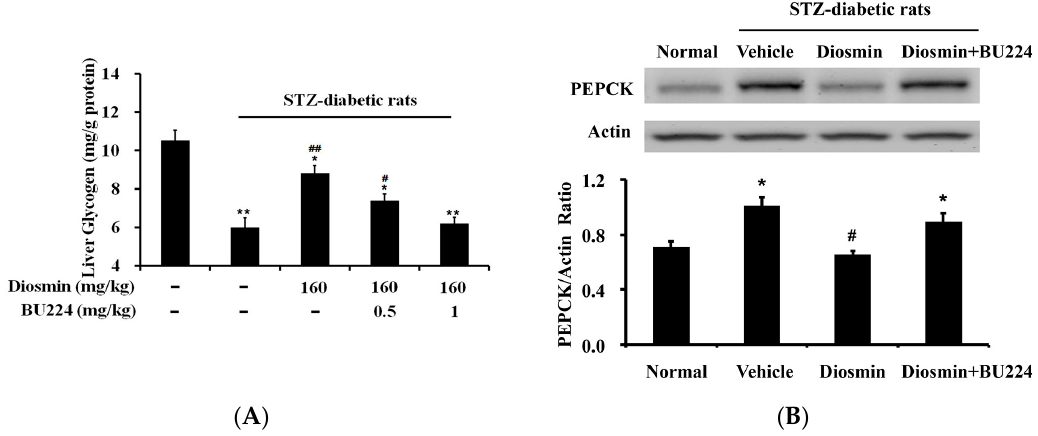
Figure 4. Effects of diosmin on the hepatic glycogen level was reduced by the blockade of I-2 receptors using an antagonist. ( A ) Hepatic glycogen (1st column) was reduced in diabetic rats (2nd column), and was increased by diosmin, shown in the 3rd column. This effect was dose-dependently inhibited by the blockade of I-2R using the antagonist BU224 (columns 4 and 5). The values are presented as mean ± SEM ( n = 8). * p < 0.05 and ** p < 0.01 compared with the basal value from vehicle-treated normal rats shown in the 1st column. # p < 0.05 and ## p < 0.01 compared with the value resulting from the treatment with diosmin (3rd column) only; ( B ) The expression of PEPCK in livers after same treatment with diosmin while the representative expression was showed in the upper. * p < 0.05 compared with the basal value from vehicle-treated normal rats shown in the 1st column. # p < 0.05 compared with the value in the vehicle-treated diabetic rats (2nd column).